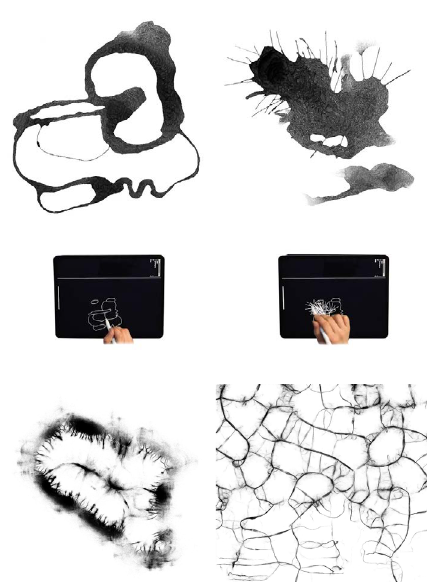
Figure 3. (a) Nonlinear behaviour of the system allows a diversity of structures to arise from the same underlying simulation mechanics and parameterization (b) Two frames showing how the scribe’s input deliberately induces an accumulation of energy, which then flows in ways the scribe has no direct control over. (12:00-13:00) (c) Two frames showing how the scribe’s input is affected by interaction between changing parameters of the system. Without additional input from the scribe, the new parameter space reconfigures the visual field and invites different interactive